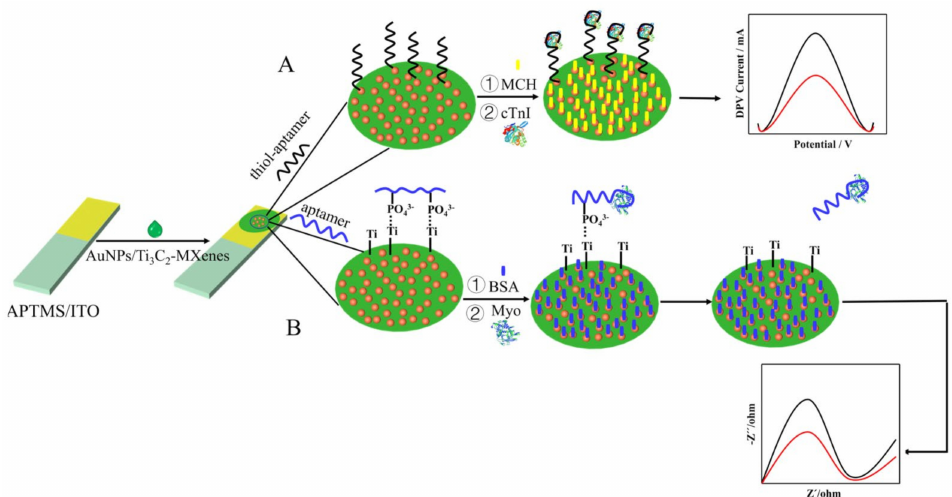
Scheme 1. Diagram of the preparation and operation process of aptasensor for dual cardiac biomark- ers based on nano-hybrid functionalized substrate electrode. “A” represents the preparation process of the cTnI aptasensor using DPV current output upon scanning potential (V); “B” represents the preparation process of the Myo aptasensor with AC impedance (Z) as output